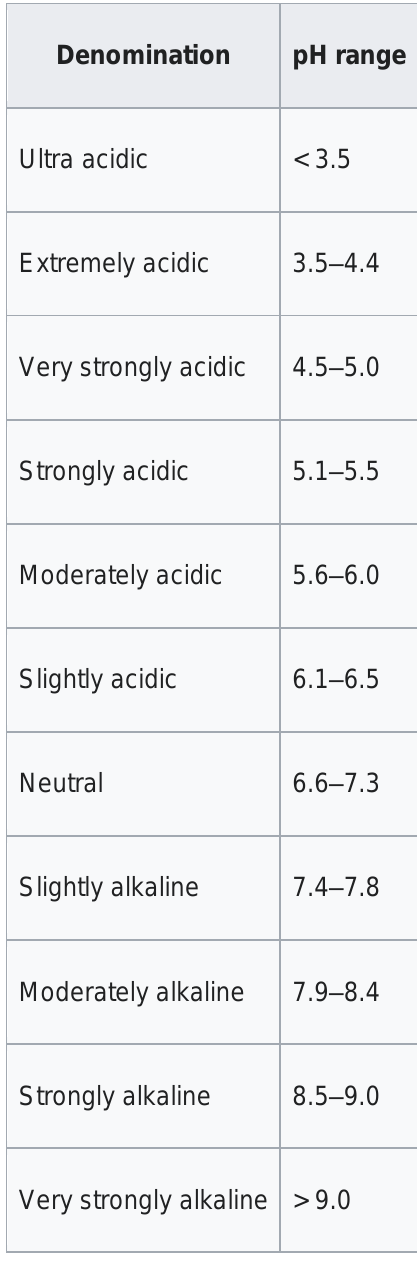
Table 1. pH range in soil